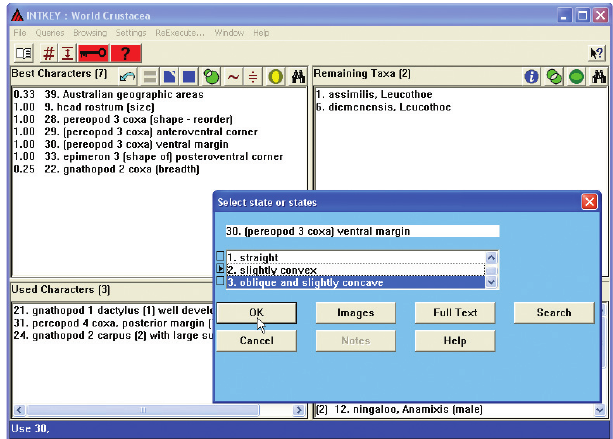
Figure 69. Using a fourth